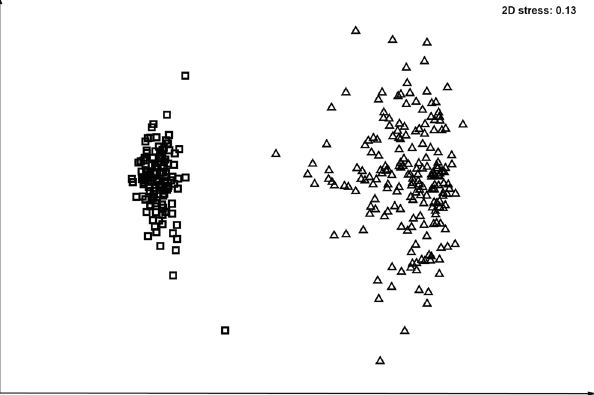
Figure 4. Global differences between anterior nasal and oropharyngeal microbial communities. Non-metric multidimensional scaling (nMDS) plot of the global bacterial community structure of 195 human anterior nasal (triangles) and 118 human oropharyngeal (squares) samples. The phylotype abundances (% sequence reads) were standardized but not transformed prior to the use of the Bray-Curtis similarity